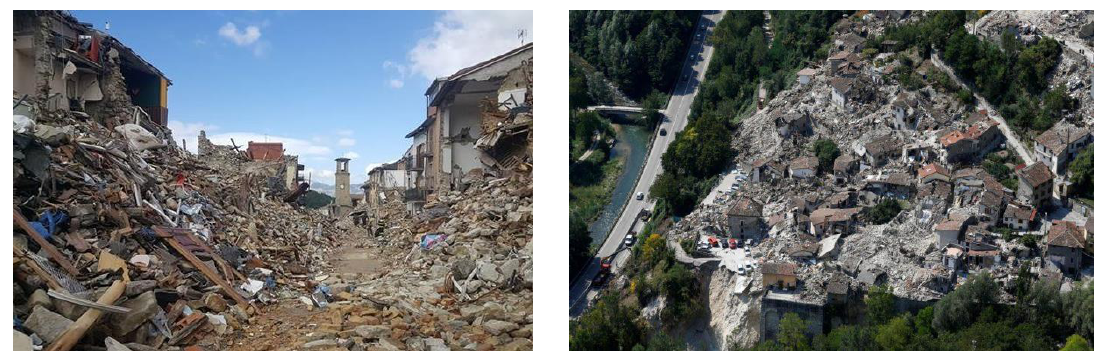
Figure 2: Diffused collapses in Amatrice (left) and aerial view of Pescara del Tronto (right, retrieved on